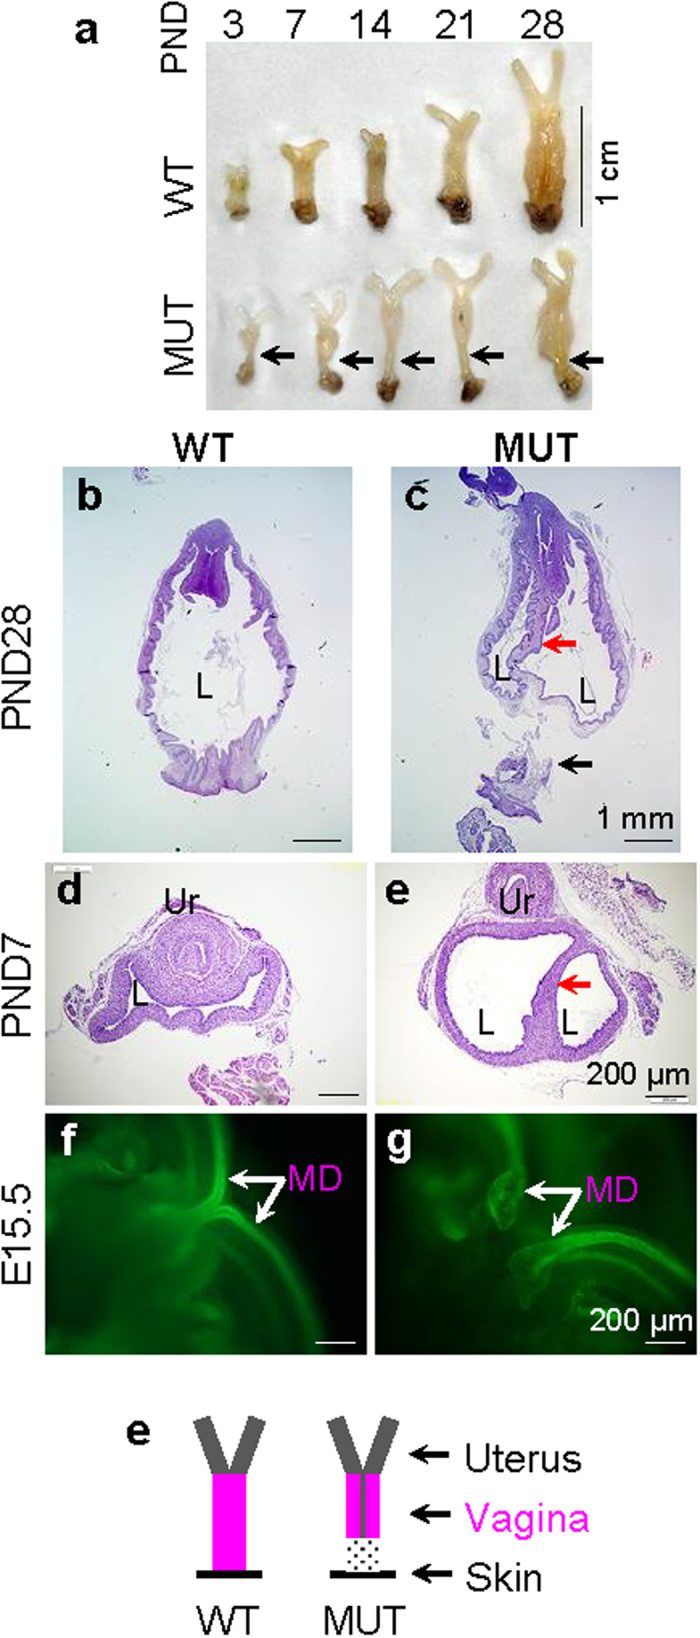
Vaginal development.(a) The appearance of WT and MUT vaginas at postnatal day (PND) 3, 7, 14, 21, and 28. (b) A longitudinal section of a WT vagina at PND28 showing single lumen. (c) A longitudinal section of a MUT vagina at PND28 showing double-lumen upper vagina and lower vagina atresia. (d) A cross section of a WT vagina at PND7. (e) A cross section of a MUT upper vagina at PND7 showing double-lumen. (f) PAX2 staining of a WT E15.5 female embryo showing Y-shaped Müllerian ducts. (g) PAX2 staining of a MUT E15.5 female embryo revealing unmerged and enlarged Müllerian duct tips. Black arrow, position of vaginal atresia; red arrow, medial wall/vaginal septum in MUT vagina; L, vaginal lumen; Ur, urethra; MD, Müllerian duct; scale bar, 1 cm (a), 1 mm (b,c), 200 μm (d–g). (h) Summary of the phenotypes in MUT female reproductive tract, including unfused upper vagina with medial wall and lower vaginal atresia. Grey line in MUT, vaginal septum; grey pattern in MUT, absence of lower vagina.